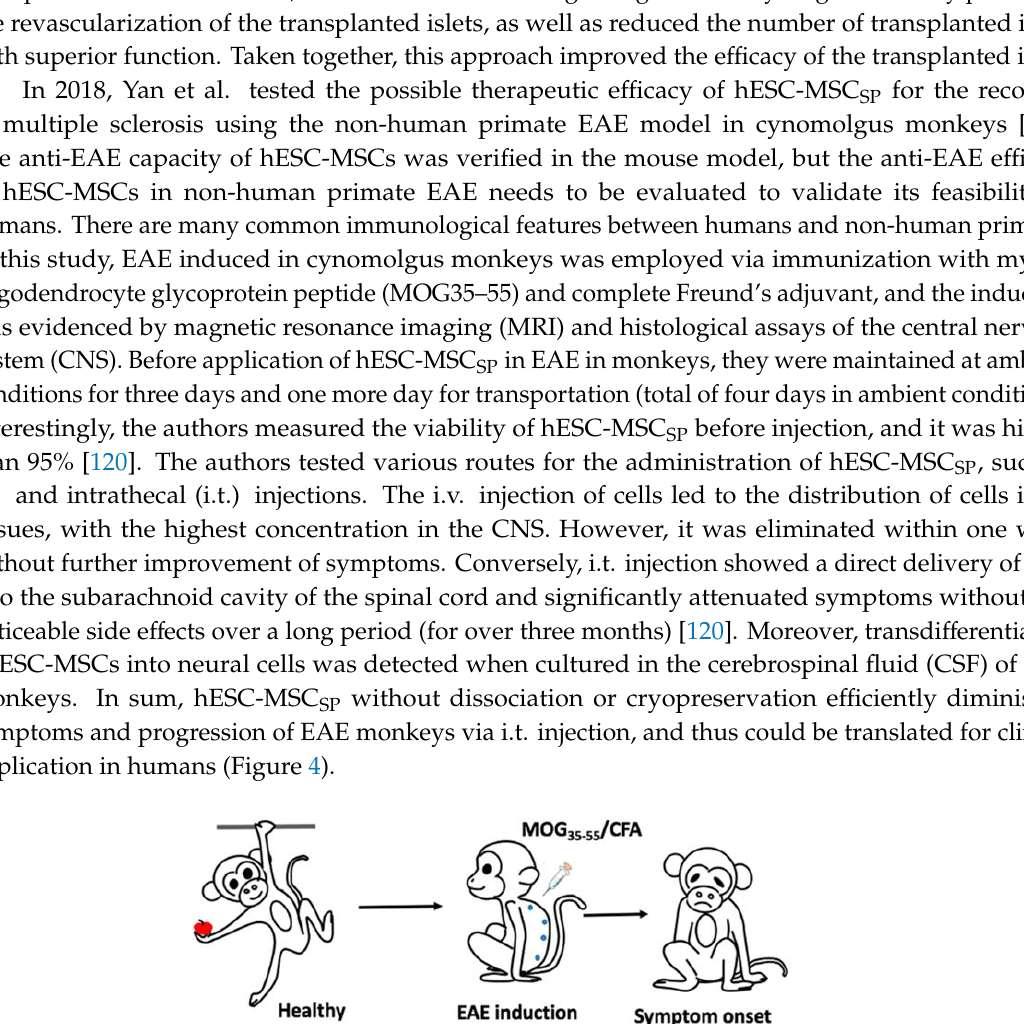
Figure 4. Schematic describing the therapeutic effect of hESC-MSC SP in experimental autoimmune